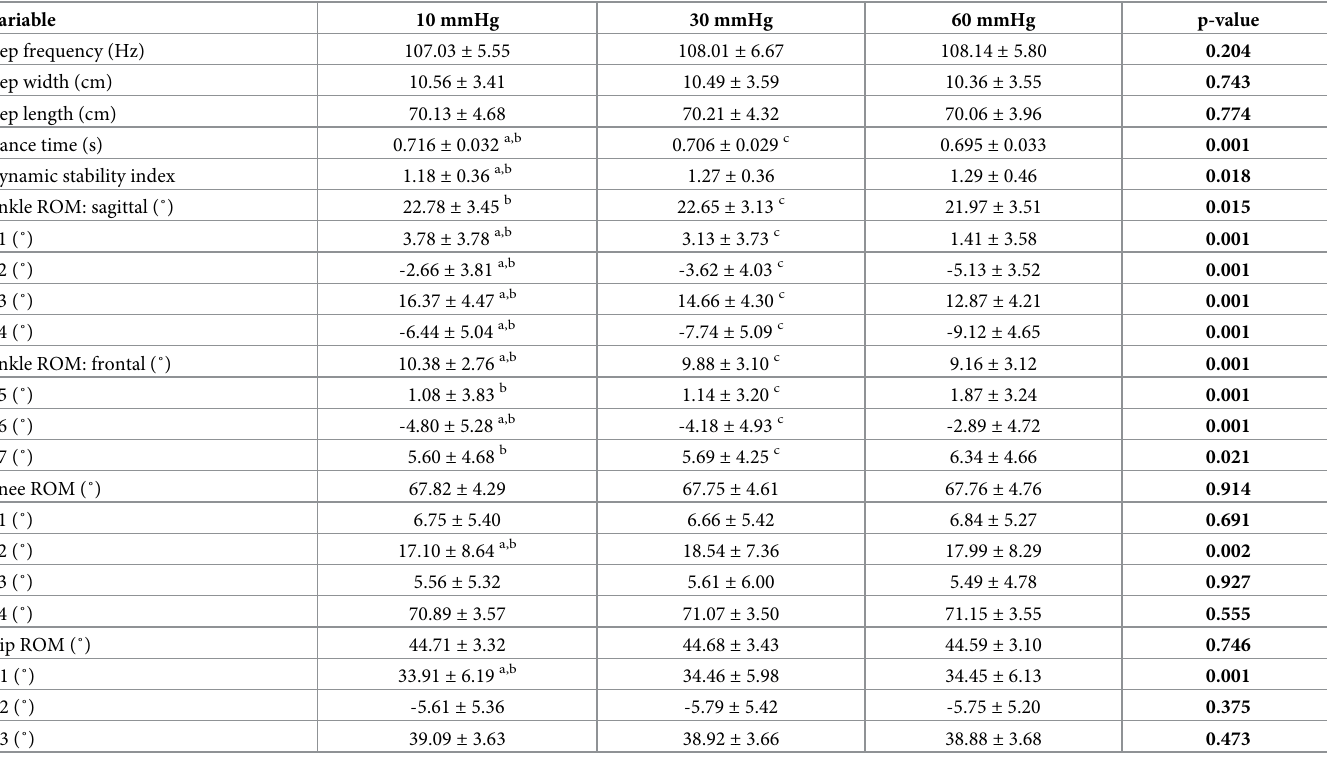
Table 1. Spatiotemporal parameters, joint angle, and dynamic stability index when walking with three shoe conditions (mean ± SD).